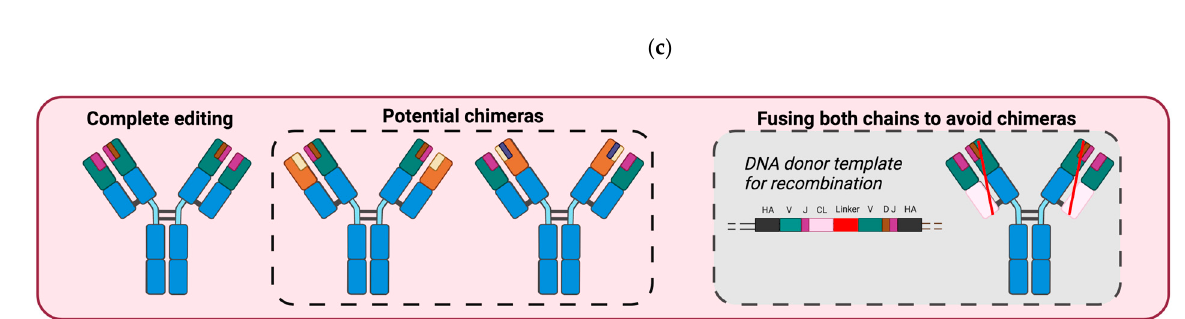
Figure 2. Editing of the endogenous BCR loci to modify B cell antigenic specificity. ( a ) Potential clinical set-up for therapies involving BCR editing. B cells are isolated by magnetic separation from the peripheral blood of patients (or of a compatible healthy donor, allogenic graft) before ex vivo editing. For editing, the CRISPR/Cas9 is used to introduce double strand breaks that are then repaired by homologous recombination if a repair template is provided by adeno-associated viral vectors. Prior to cell reinfusion in the patient, a safety step should be added to check both the editing and the OFF target mutations. ( b ) BCR loci before and after editing. Three distinct genes encode the BCR: one for the heavy chain (right) and two for the light chain (kappa or lambda, left). Of note, only one light chain gene is expressed per cell, either kappa or lambda. The recognition specificity of the BCR is determined both by the combination of a variable (V), a diversity (D) and a joining (J) region on the heavy chain and by the combination of a variable (V) and a joining (J) region on the light chain (top). The constant regions (blue) are not involved in antigen recognition directly but in the triggering of effector responses. Initially, the first constant domains (u and d) are expressed leading the IgM or IgD antibodies. After B cell activation by a process called isotypic class switching, these first constant domains can be genetically excised and the following constant domains are expressed leading to either IgG, IgA or IgE antibodies. Most editing strategies are aimed at introducing a new VDJ combination into the heavy chain locus just before the constant domains in order to change the BCR specificity. This insertion can be performed after introduction of double strand break with the CRISPR/Cas9 system into the heavy chain locus, and the new VDJ combination is inserted using a donor template that harbors homologous arms for recombination on each side of the VDJ sequence to introduce. Similarly, the light chain loci can also be edited concomitantly to modify both chains. However, this often results in poor editing rates, due to low recombination efficiency. To counteract this issue, the whole light chain domain can be inserted along with the VDJ heavy chain domain into the heavy chain locus. ( c ) BCR chain chimeras can arise if the editing is incomplete. If only one chain is edited, it will pair with the endogenous version of the other chain, which can modify the specificity of the BCR and might lead to autoimmune reaction. To avoid this mispairing, one study physically linked the light and heavy chains in order to force proper pairing (bottom right). In this case, the donor template contains the whole light chain and the VDJ domain of the heavy chain with a linker in between. This cassette is flanked by homologous arms for insertion into the heavy chain locus just before the first constant domain by homologous recombination.